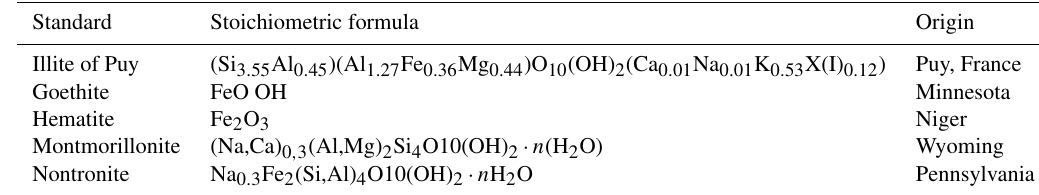
Table 1. Characteristics of the standards used for the quantification of the iron oxides in the XAS analysis.